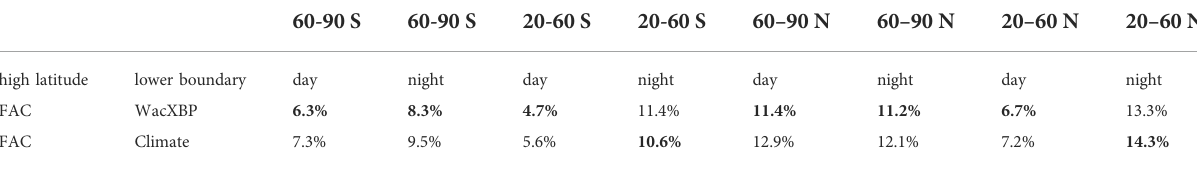
TABLE 4 Relative error of the disturbance neutral density variation (by removing the average quiescent time variation of doy 30 UT 0 – 22) for using WacXBP and climatology at the lower boundary with respect to the absolute observed neutral density | Δ ρ model − Δ ρ data | 1 /| ρ data | 1 for doy 30.0 to